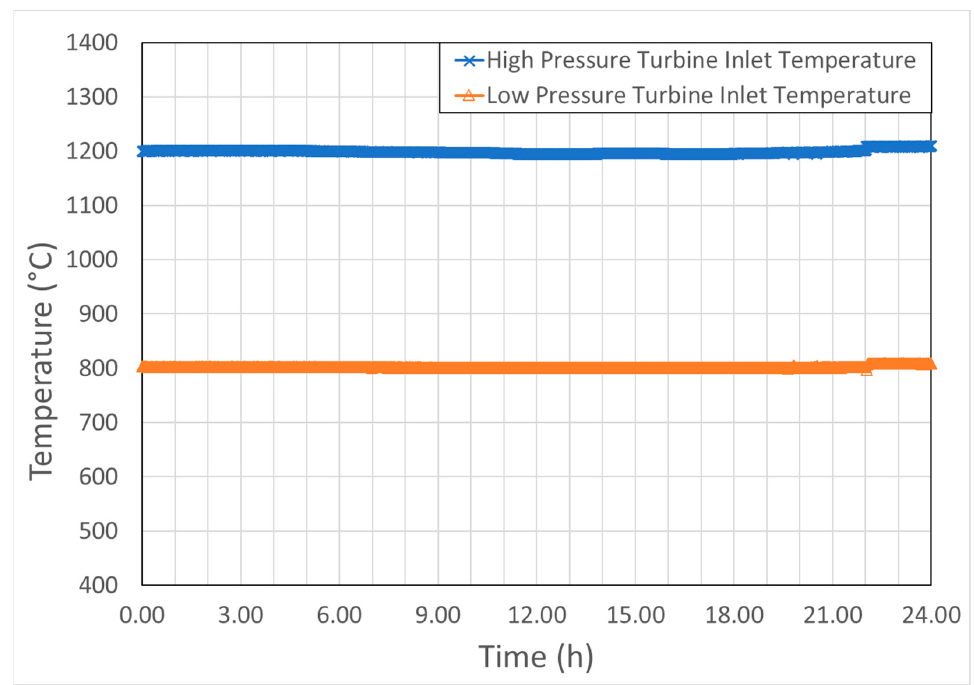
Figure 4. High Pressure and Low Pressure Turbine Inlet Temperatures.